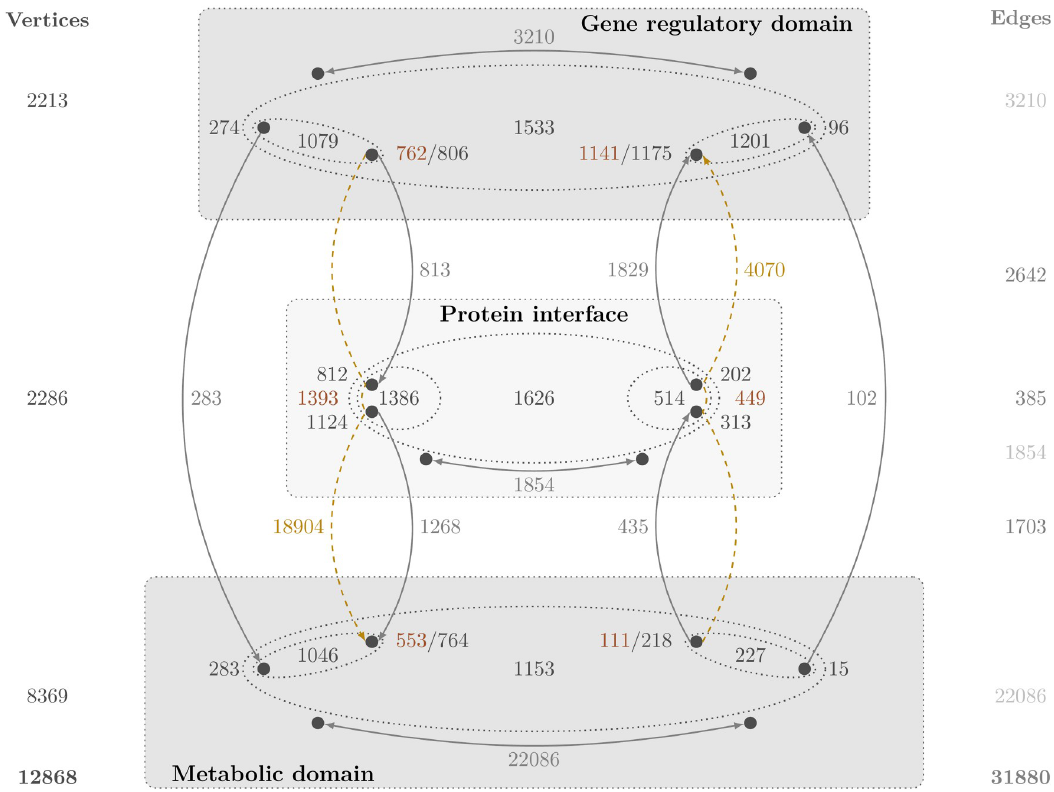
Fig 5. Schematic overview of the components and connections of the integrative E. coli network, especially those involved in the protein interface. The information about edges are presented in gray and about traversing paths are shown in gold while the number of vertices are shown in dark blue and the traversing paths-related ones are given in dark brown, in addition. The solid lines denote direct link connections while the dashed lines the traversing paths connections. In the regulatory domain, for example, 274 vertices are directly linked to 283 vertices in the metabolic domain via 283 edges. Also, 806 vertices have a directed edge to 812 vertices in the protein interface (summing up to 813 edges). Similarly, the regulatory domain has 3210 edges residing in this domain. The total number of vertices in the regulatory domain that exchange an incoming or outgoing link with one of the other domains are 1533. The number of edges displayed on the right-hand side of the figure is the total count of edges between two domains or within a single domain. The number 385, for example, is the total count of edges between the regulatory domain and the metabolic domain. The number 1854 is the total count of edges within the interface domain. In gold (as numbers and dashed lines) the information about traversing paths is given. The total number of downwards traversing paths (18904) and of upwards traversing paths (4070) is indicated in gold along these dashed